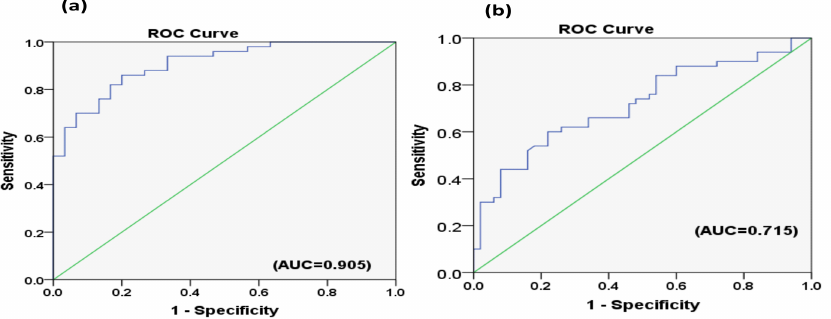
Figure 4. ROC curve analysis. ( a ) Smoker group: auto-antibodies against N-OH-AABP-modified human DNA can distinguish bladder cancer patients from controls (AUC = 0.905). ( b ) Non-smoker group: the relatively low presence of auto-antibodies against N-OH-AABP-modified human DNA in the non-smoker group of bladder cancer patients (AUC = 0.715). ROC, receiver operating characteris- tic; AUC, area under the